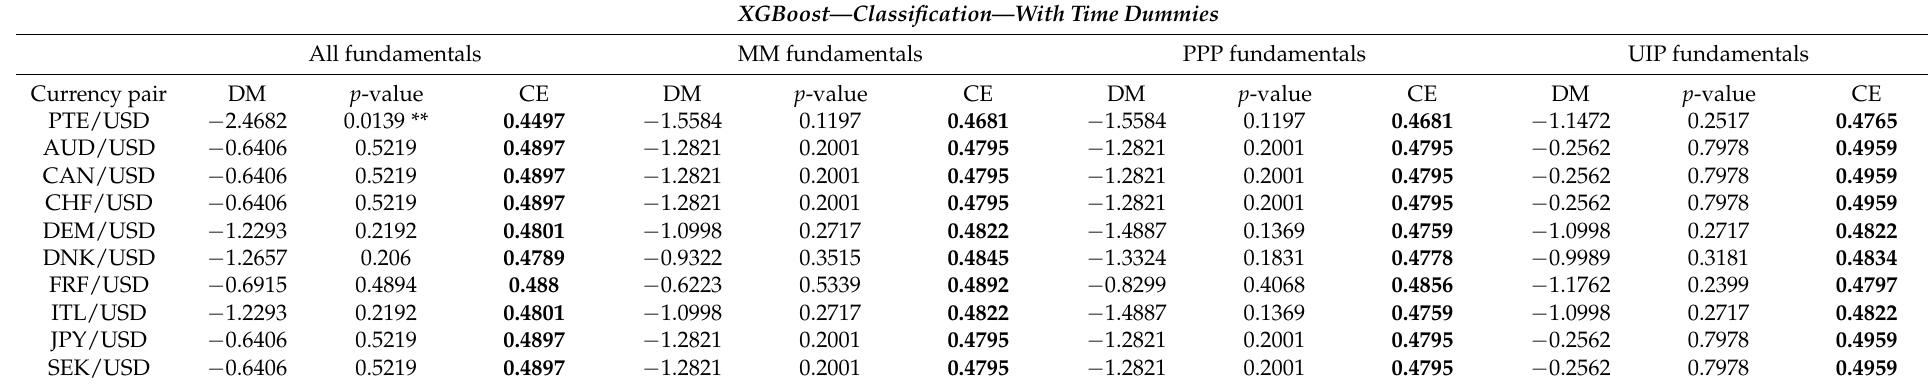
Table 3. One-month-ahead forecasting of exchange rate direction with fundamentals using XGBoost. XGBoost—Classification—With Time